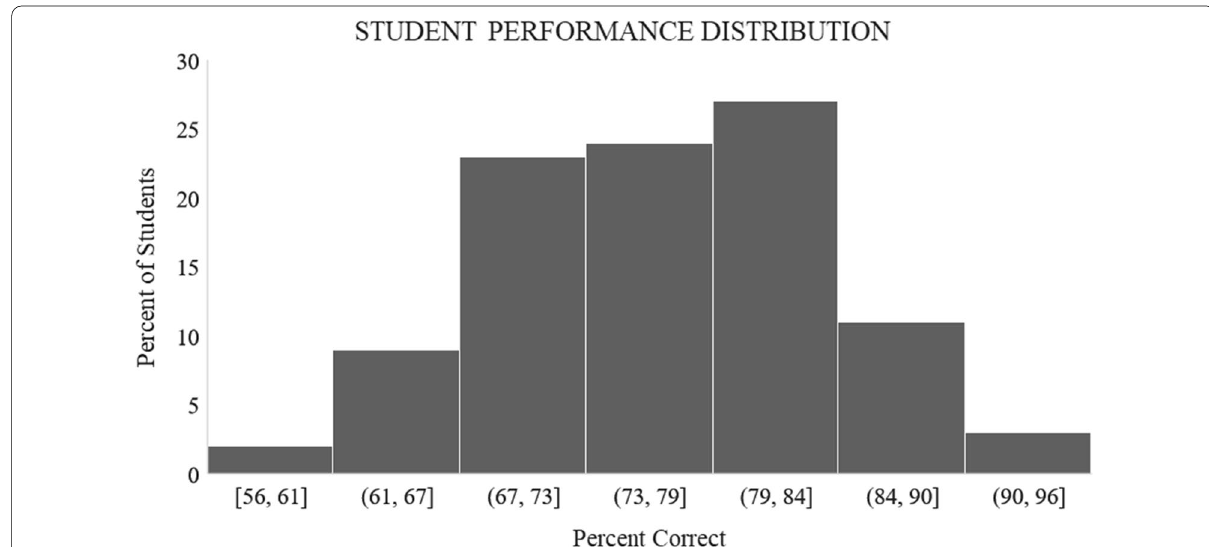
Fig. 2 Frequency distribution of students’ overall percent of correct items for the final version of the PSKA instrument in Spring 2019. Each bar represents the percentage of students whose test scores fall within the given percent correct bins. n